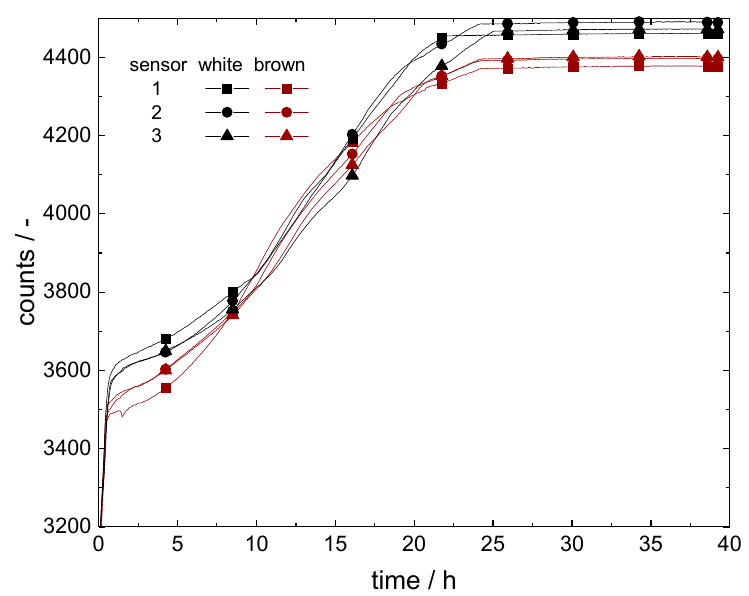
Figure 3. Drying experiment in air at 25 °C: counts are plotted versus time in hours; ceramic drying curves of six different TDT circuit sensors: three sensors with brown and three sensors with white ceramic discs.